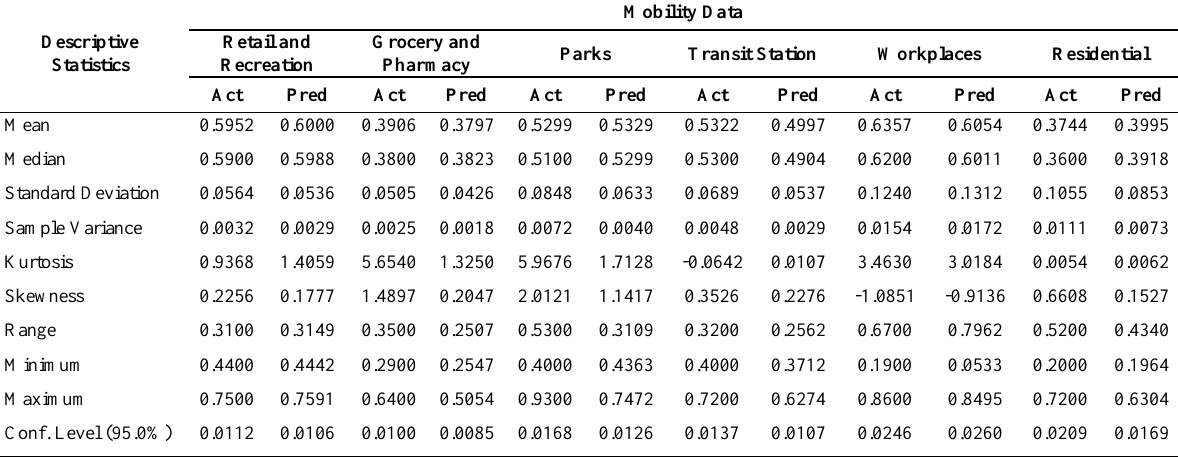
Table 4. Descriptive statistics of actual values compared to predictions made by GA